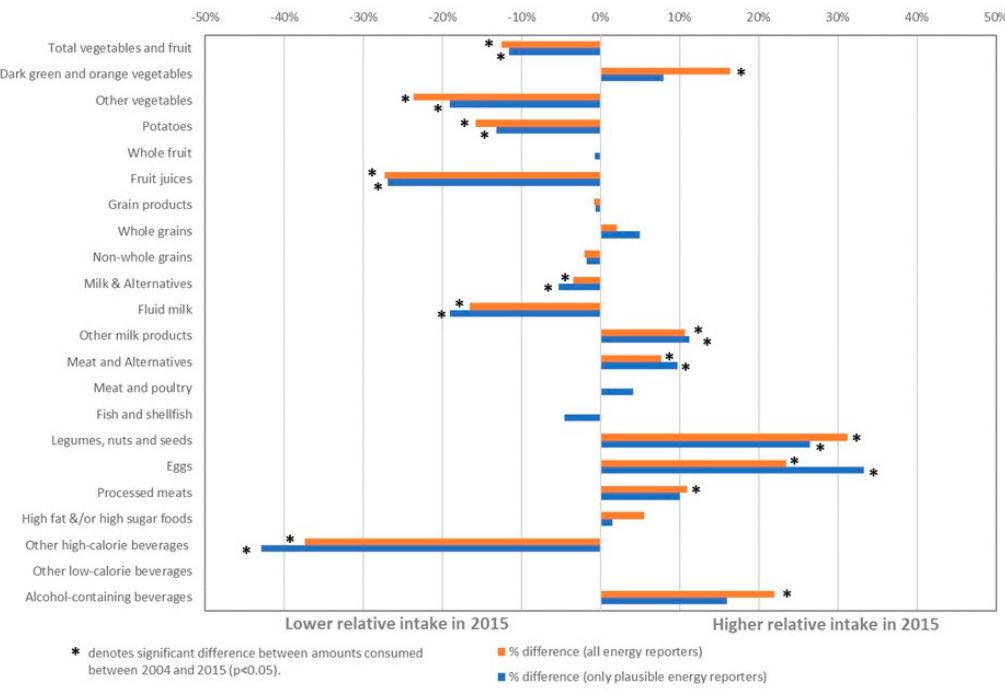
Figure 2. Relative percent (%) change in mean daily intakes of foods among Canadians age 2 years and older 1 between 2004 and 2015. 1 Average intake from alcohol-containing beverages estimated for respondents aged 13 years and older